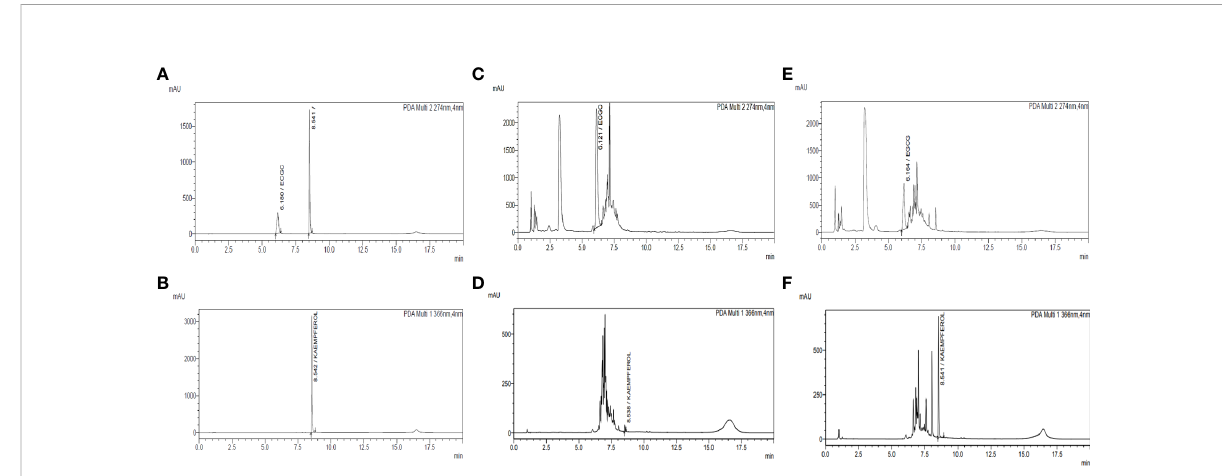
FIGURE 2 Quanti fi cation of EGCG and kaempferol by UPLC-PDA in C. sinensis hydroethanolic extract and kaempferol-enriched C. sinensis extract. (A) Chromatogram of the standard mixture of kaempferol and EGCG at 274 nm. (B) Chromatogram of the standard mixture of kaempferol and EGCG at 366 nm. (C) Chromatogram of C. sinensis hydroethanolic extract (USCSE) at 274 nm. (D) Chromatogram of C. sinensis hydroethanolic extract (USCSE) at 366 nm. (E) Chromatogram of kaempferol enriched C. sinensis extract (USKECSE) at 274 nm. (F) Chromatogram of kaempferol enriched C. sinensis extract (USKECSE) at 366